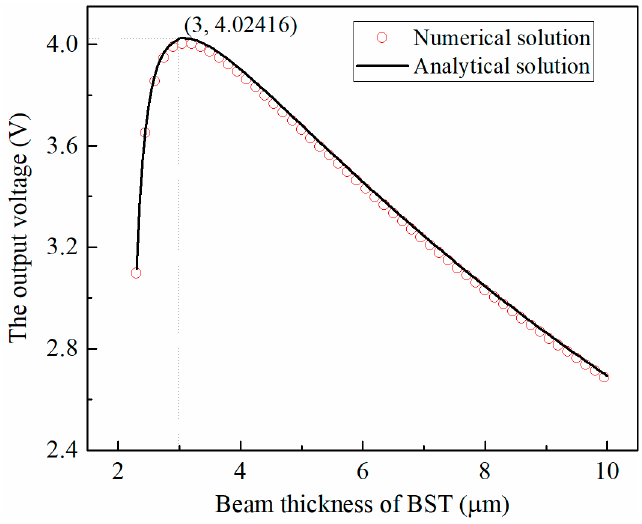
Figure 5. Output voltage of three-layer micro scale flexoelectric laminated beam under static load. Setting the thickness of the BST layer (3 µ m) and the uniform load q = − 100 µ N/m applied to each BST layer, the variation law of the output voltage of the BST/PDMS flexoelectric laminated cantilever structure with the number of BST layers under different PDMS layer thicknesses is shown in Figure 6.